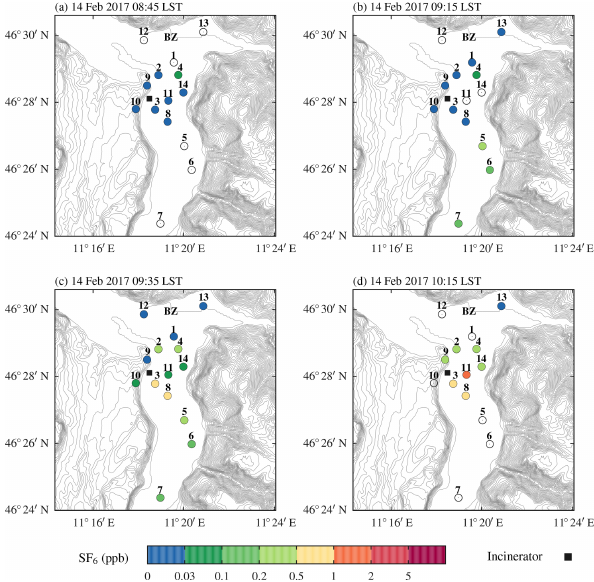
Figure 9. Spatial distribution of the tracer concentrations measured during the release performed in the morning of 14 February 2017. The position of the city of Bolzano is indicated on the map with the label BZ.